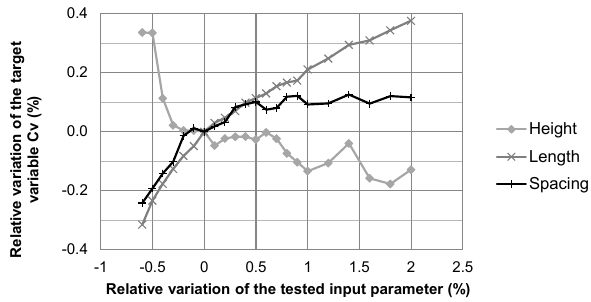
Figure 9. Graph showing the influence of the structure parameters (spacing E , height h , length L ) of the agrivoltaic installation on the spatial heterogeneity of rain redistribution by the solar panels, from the simulated values of the coefficient of variation